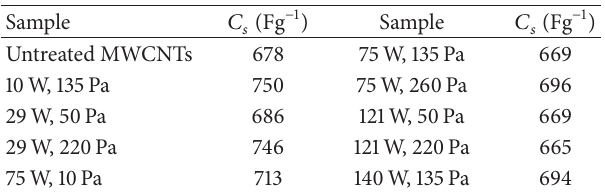
Table 1: Specific capacitance values of untreated and water plasma- composite at a scan rate of 10mVs − 1 treated CNTs/MnO 2